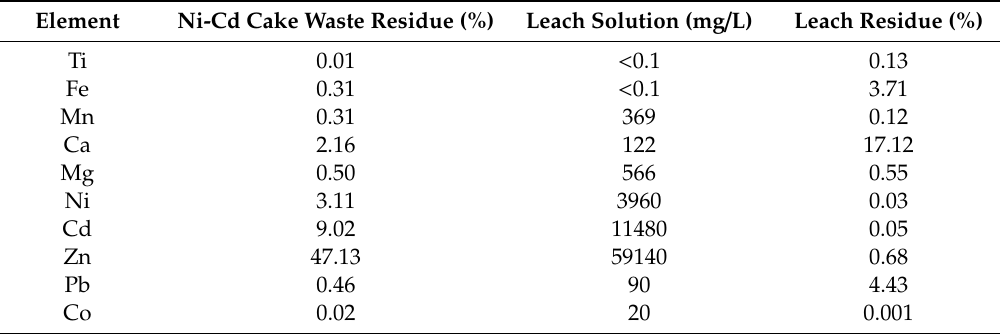
Table 2. Chemical composition of Ni-Cd waste residue, leach solution and leach residue.